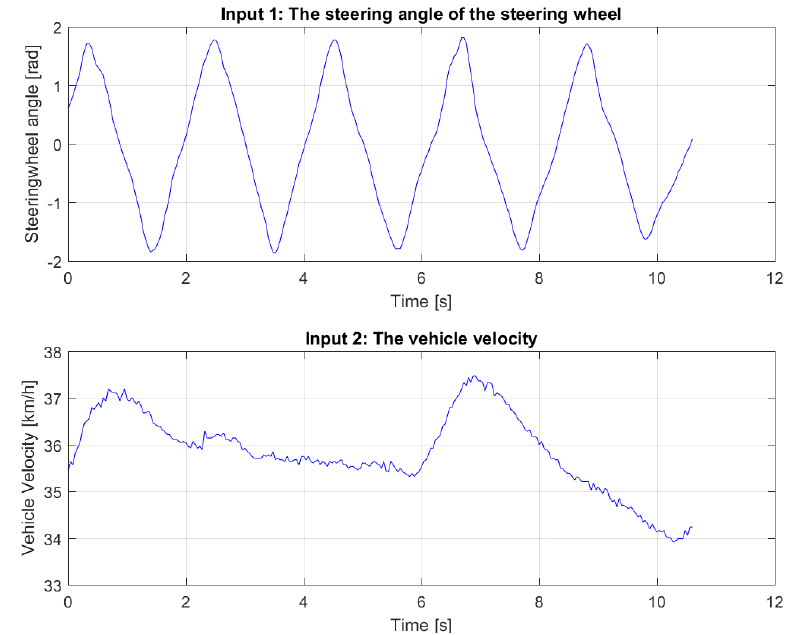
Figure 3. The inputs of one dataset.